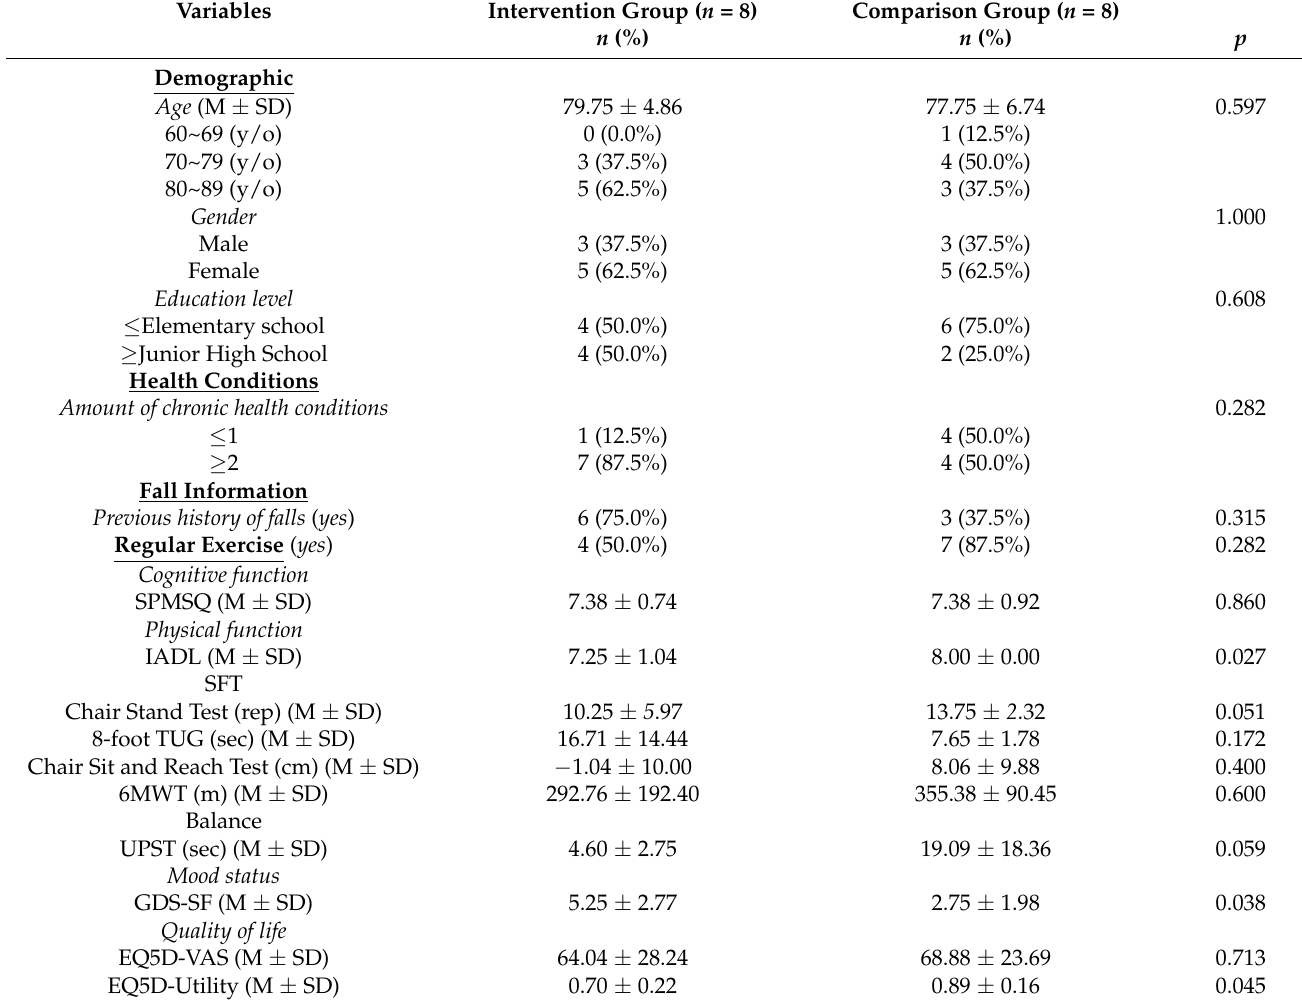
Table 3. Participant characteristics in demographic data of both groups (N =